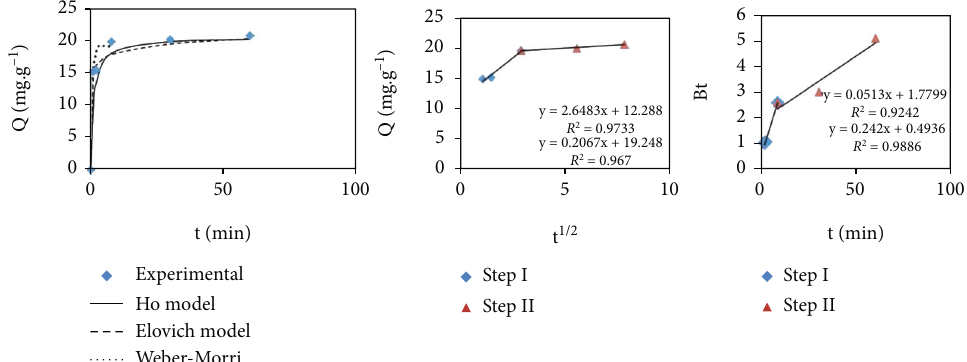
Figure 7: Experimental curves and the Ho, Elovich, and Webber-Morri models of the kinetic study of Ni(II) ion adsorption on sodic clay.